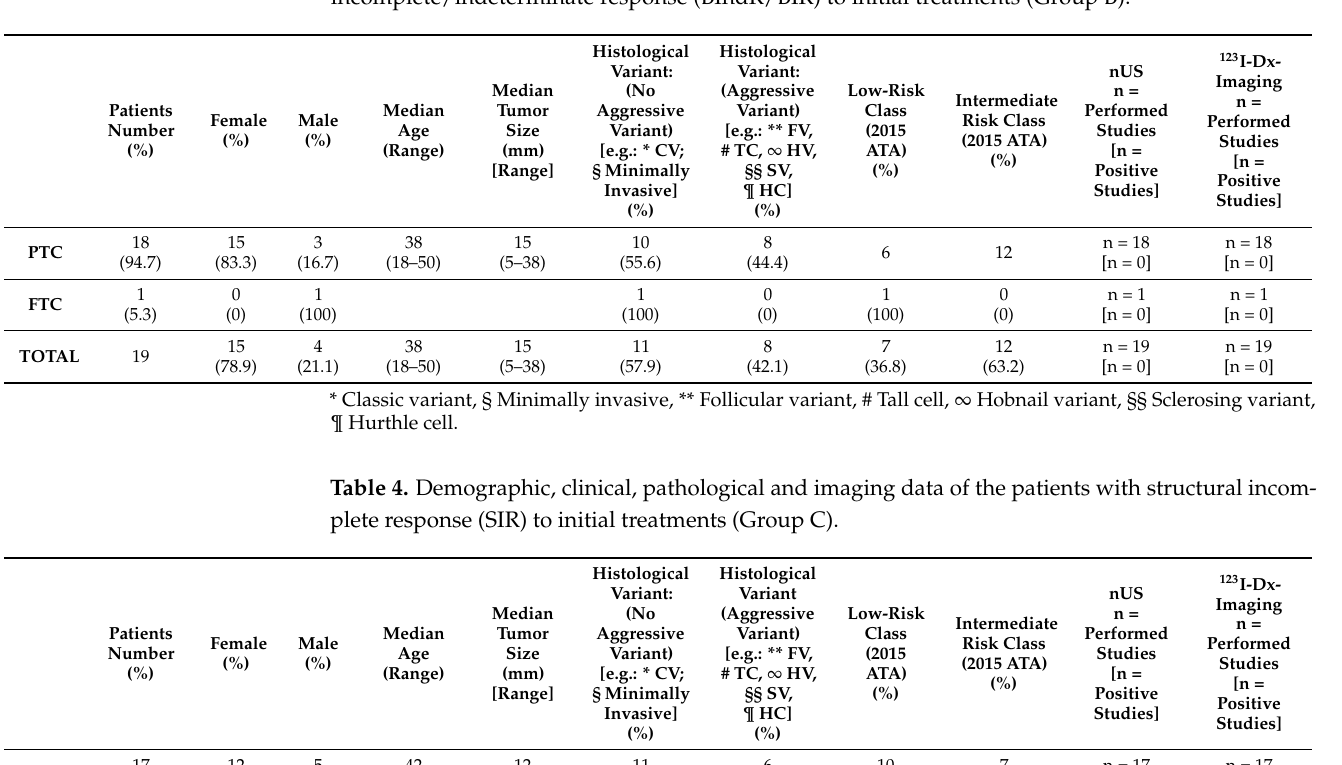
Table 3. Demographic, clinical, pathological and imaging data of the patients with biochemical incomplete/indeterminate response (BIndR/BIR) to initial treatments (Group B).